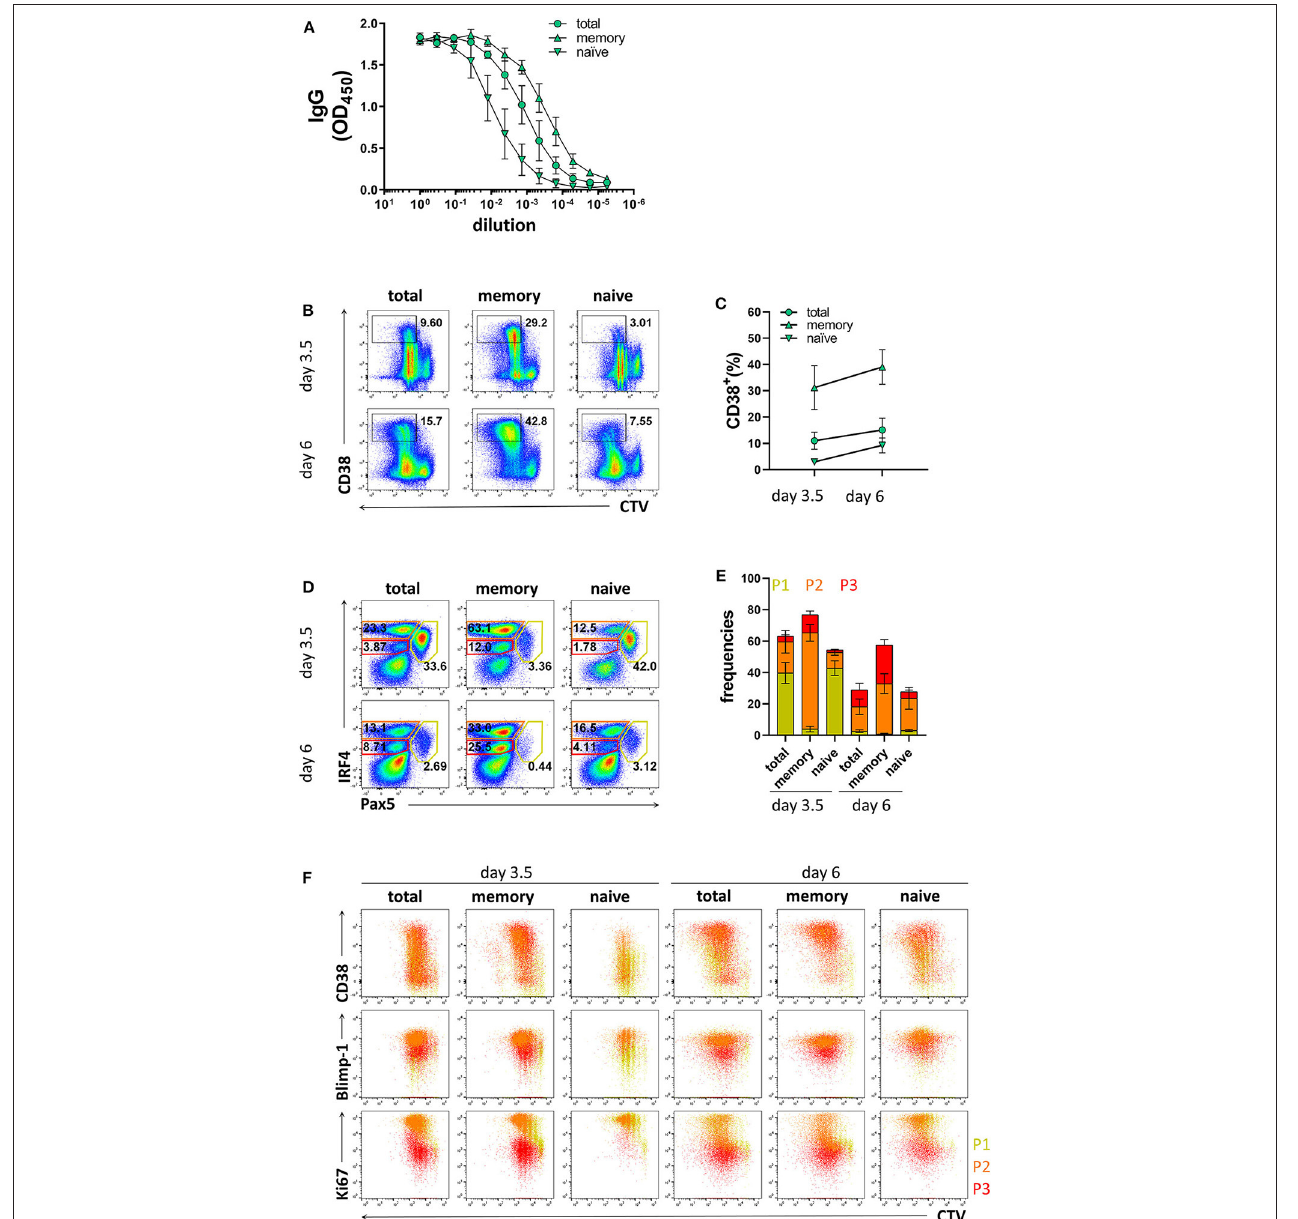
FIGURE 3 | Differentiation of memory B cells and naïve B cells in vitro . Memory B cells, naïve B cells, and total B cells were isolated from healthy donors, cultured with stimulation III, and analyzed by flow cytometry at day 3.5 and day 6. Cells were pre-gated on FSC-A/FSC-W to identify singlets and on FSC-A/SSC-A to identify lymphocytes. (A) Total IgG production from supernatant of cultured cells at day 6 was evaluated by ELISA. Each line and error bar indicate mean ± s.d. (B) Representative plots showing gating strategy for CD38 + population. Numbers adjacent to gates indicate cell frequencies. (C) Frequencies of CD38 + cells with symbols and error bars indicating mean ± s.d. (D) Representative plots showing gating strategy for IRF4 lo Pax5 hi (P1), IRF4 hi Pax5 lo (P2), and IRF4 int Pax5 lo (P3) populations. Numbers in or adjacent to gates represent cell frequencies. (E) Frequencies of IRF4 low Pax5 hi (P1), IRF4 hi Pax5 lo (P2), and IRF4 int Pax5 lo (P3) populations. Bars and error bars indicate mean ± s.d. (F) Plot overlays showing CD38, Blimp-1 and Ki67 expression for IRF4 low Pax5 hi (P1), IRF4 hi Pax5 lo (P2), and IRF4 int Pax5 lo (P3) populations. Data are representative of three independent repeats with 3–5 donors per experiment.